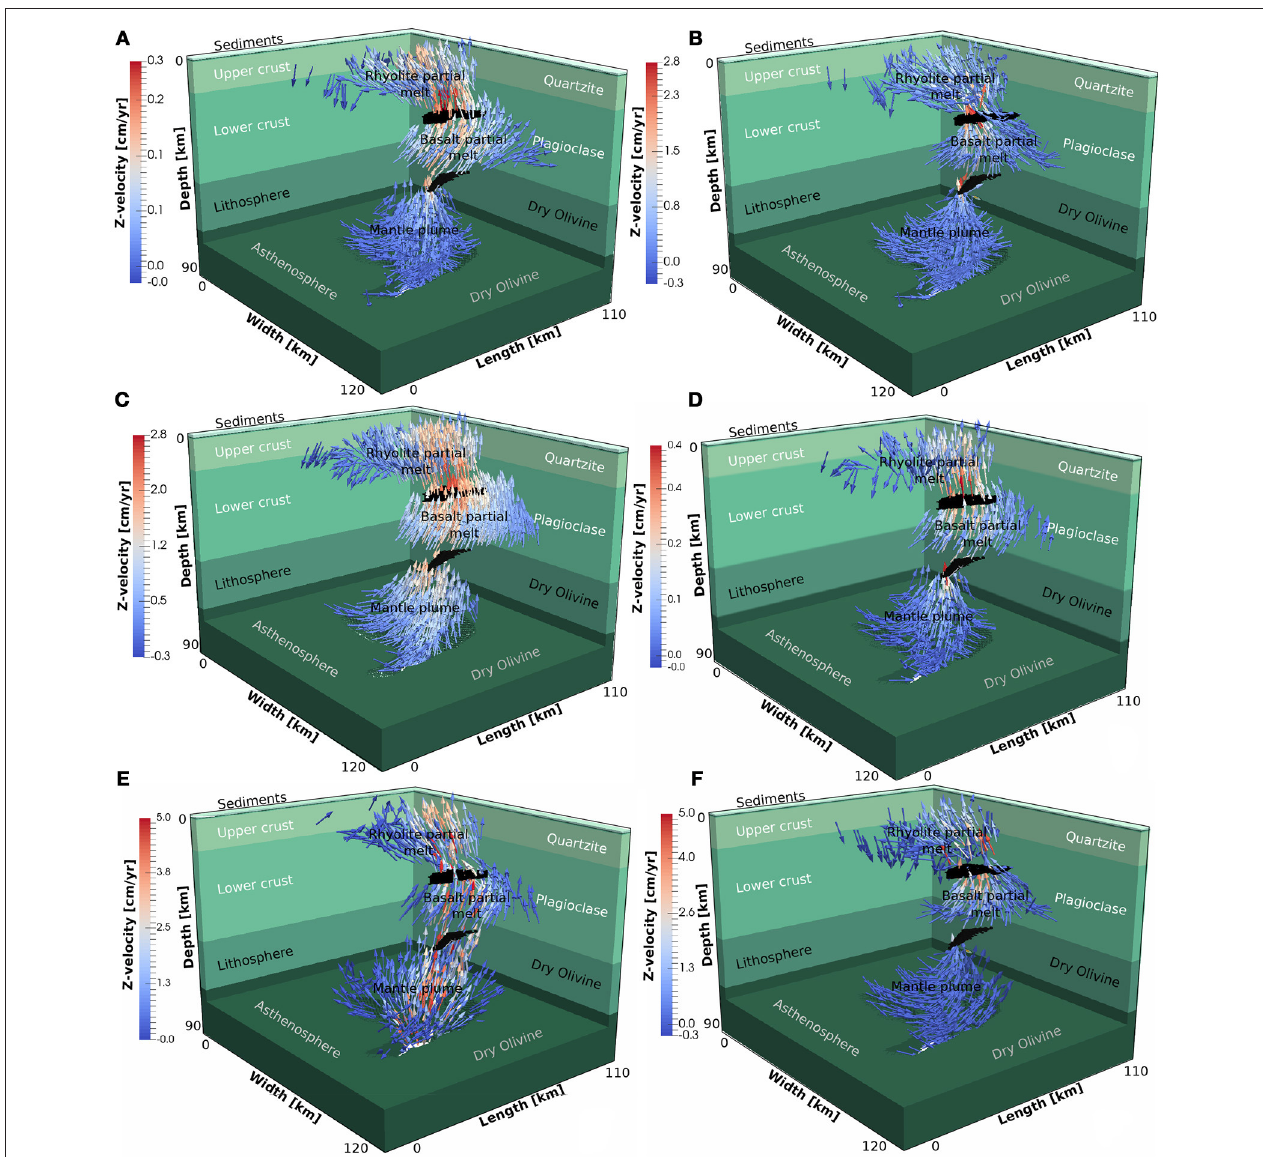
FIGURE 5 | Summary of the velocity structure of different end member simulations. (A) No connection between the reservoirs and no plasticity. Maximum vertical velocities at the surface are 0.2 cm/year. Black parts show the connection between the reservoirs which is set to the surrounding crustal viscosities in case they are inactive. (B) Connections between the reservoirs and no plasticity. Maximum vertical velocities at the surface are 0.8 cm/year. (C) Connections between the reservoirs and plasticity. Maximum vertical velocities at the surface are 1.2 cm/year. (D) Connections between the reservoirs, plasticity and a higher viscosity of the reservoirs of 10 21 Pa s, implying a lower melt content. The maximum vertical velocity at the surface is 0.2 cm/year. (E) Case with slightly larger connections between the reservoirs, plasticity and a basal boundary overpressure of 50 MPa. Maximum vertical velocity at the surface is 2.4 cm/year. (F) Case with a prescribed kinematic boundary condition between the reservoirs to simulate influx from the middle to the upper reservoir of around 8 cm/year. Maximum vertical velocity at the surface is 2 cm/year. The downwards center of the reservoir is moving upwards which must result in a (low magnitude) downwards movement of material